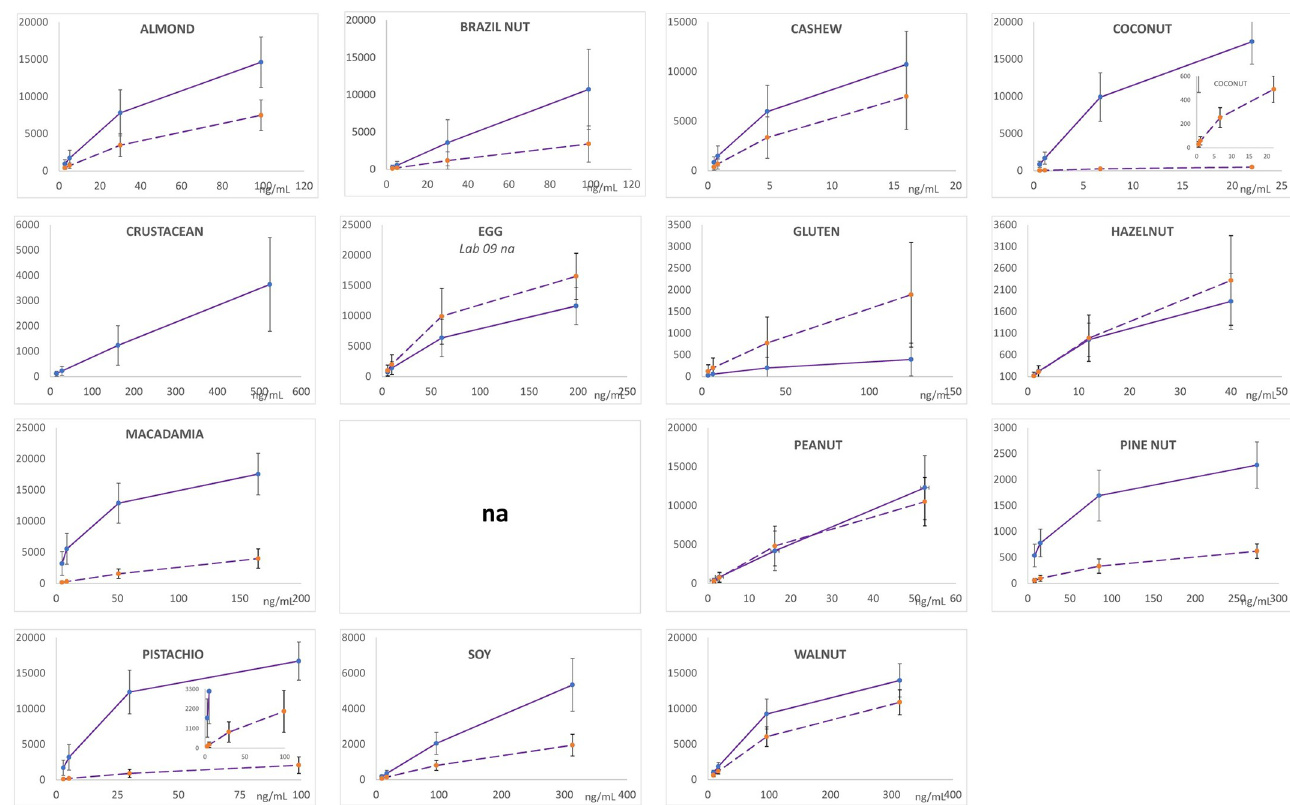
Fig 2. Calibration standards prepared in UD buffer. Similar to Fig 1 except UD buffer used as the solvent.